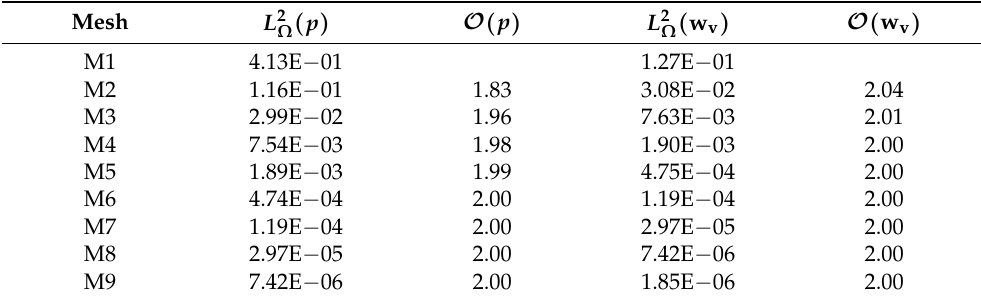
Table 2. Spatial L 2 error norms and convergence rates at time t = 0.1 obtained using the LADER scheme for the Taylor-Green vortex benchmark in